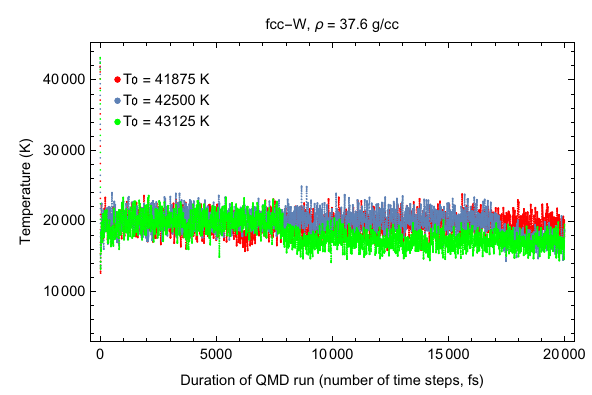
Figure 14. The same as in Figure 1 for fcc-W.